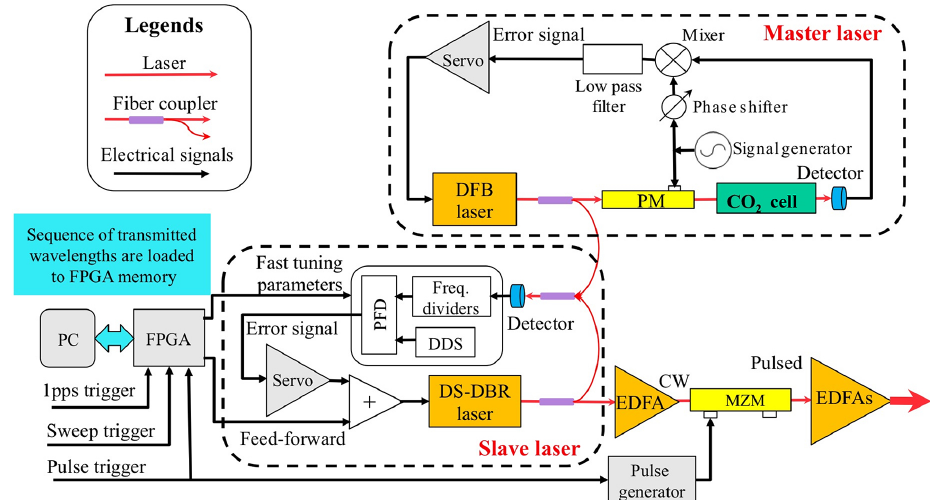
Figure 3. Block diagram of the CO 2 seed laser subsystem that is used to produce the wavelength-stepped pulse train transmitted by the lidar. The wavelength of the master laser (a DFB laser diode) is frequency locked to the center of the CO 2 absorption line. The slave laser is offset-frequency-locked to the master via an optical-phase-locked loop. The frequency offset is changed during the 99µs between laser pulses based on the wavelength settings stored in a table in the seed laser’s FPGA. The slave laser’s output is modulated into 1µs wide pulses by the modulator (MZM) and is used as the input for the transmitter’s fiber amplifiers (EDFAs) that produce the laser pulse train that is transmitted. Here PM denotes phase modulator; PFD, phase frequency detector; FPGA, field programmable gate array; DDS, direct digital synthesizer; MZM, Mach–Zehnder modulator; and EDFA, erbium doped fiber amplifier.